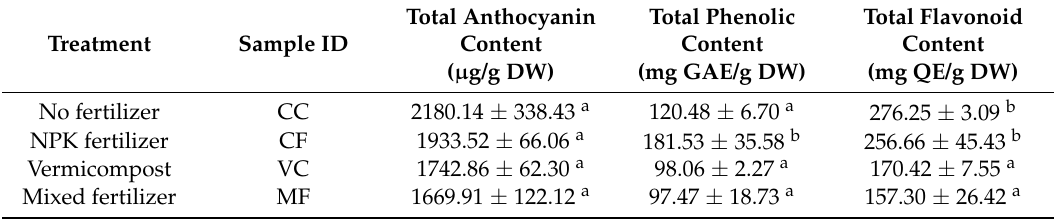
Table 2. Effect of plant growth supplementation on total phenolic, anthocyanin, and flavonoid contents in methanolic extracts of C. nutans